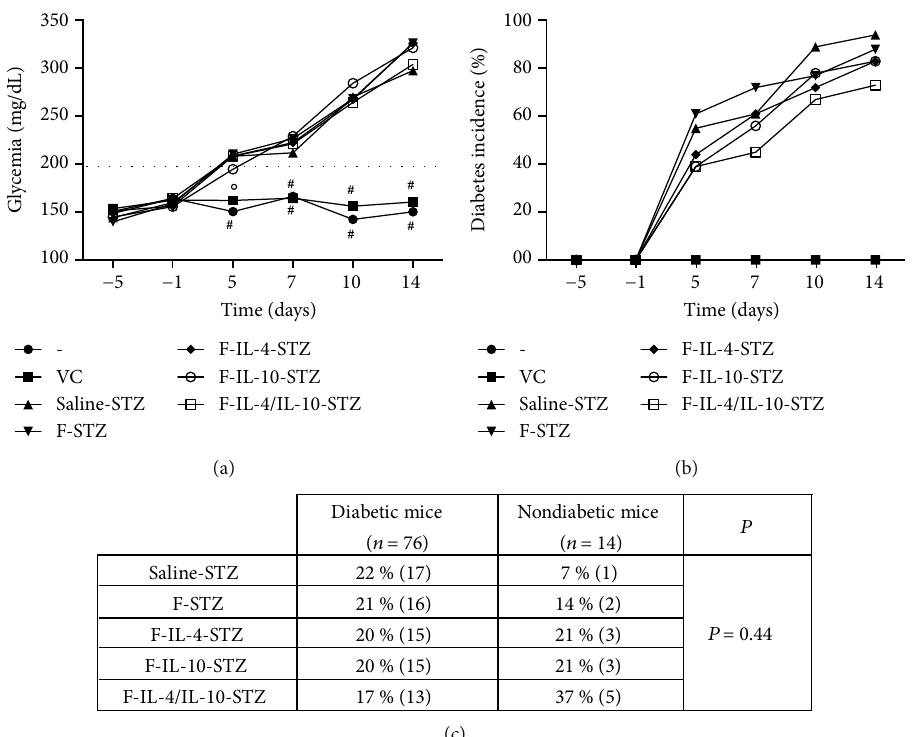
Figure 2: Clinical e ff ects of genetically modi fi ed L. lactis strains encoding IL-4 and IL-10 in the STZ-induced diabetes model. C57BL/6 mice were injected with 0.9% saline, vehicle solution, or STZ for fi ve consecutive days (50 mg/kg/d). Speci fi c bacterial administration was performed daily by the intragastric route from day -5 to day 7. (a) Glycemic levels (mg/dL) were measured at days -5, -1, 5, 7, 10, and 14. The data are shown as the mean ± SD of three independent experiments ( n = 18 ). #: experimental group whose glycemia was signi fi cantly di ff erent from the saline-STZ, F-STZ, F-IL-4-STZ, F-IL-10-STZ, and F-IL-4/IL-10-STZ groups; ° : experimental group whose glycemia was signi fi cantly di ff erent from the saline-STZ, F-STZ, F-IL-4-STZ, and F-IL-4/IL-10-STZ groups. (b) Diabetes incidence over time was analyzed, and (c) the percentage of diabetic and nondiabetic mice between the experimental groups and the disease control group at day 14 was compared. p value: p ≤ 0 : 05